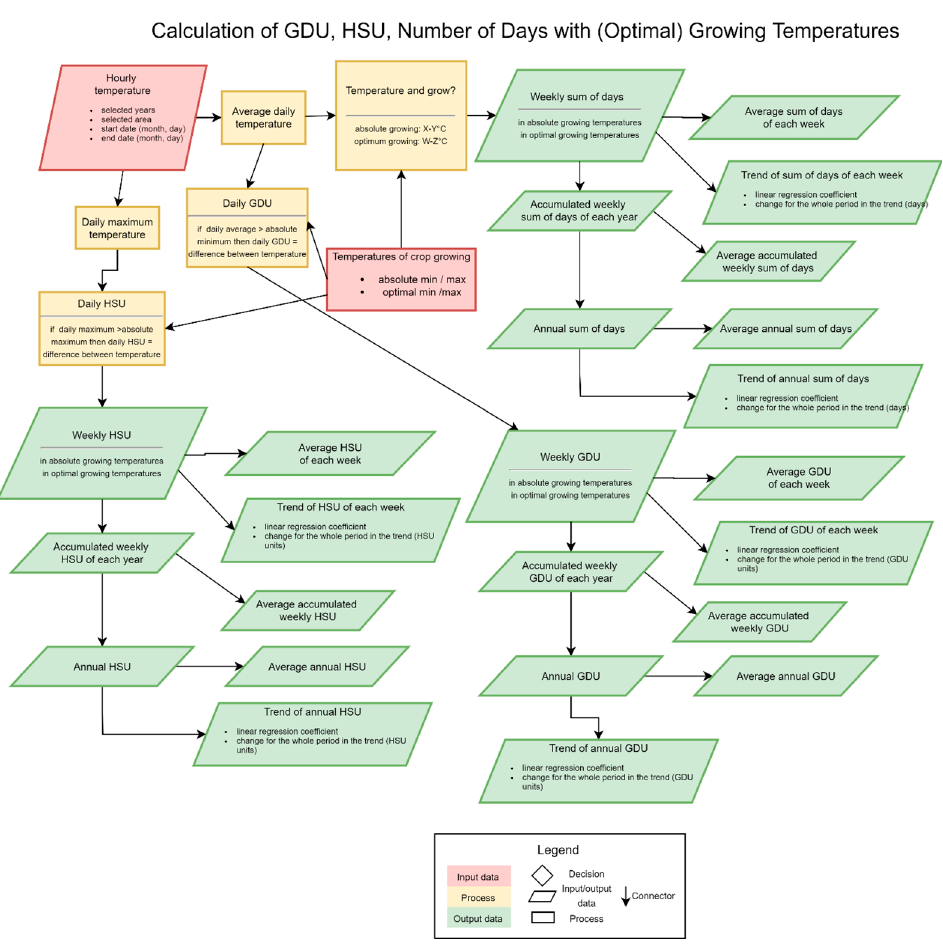
Figure 4. Scheme of the algorithm for calculation of growing degree units (GDU), heat stress units (HSU), and the number of growing days (adapted from [29]).